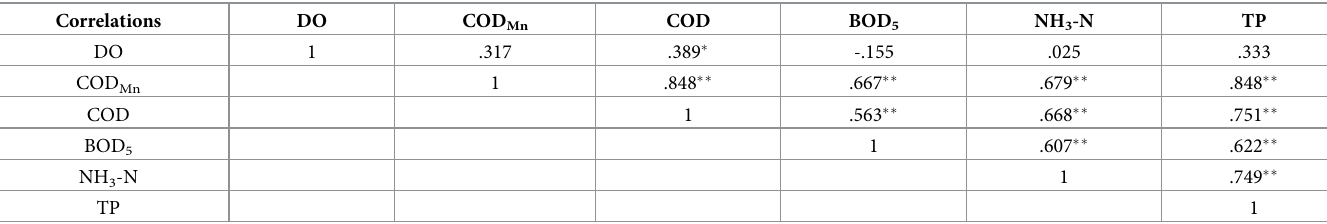
Table 7. Pearson correlation analysis of major elements exceeding the standard limits.